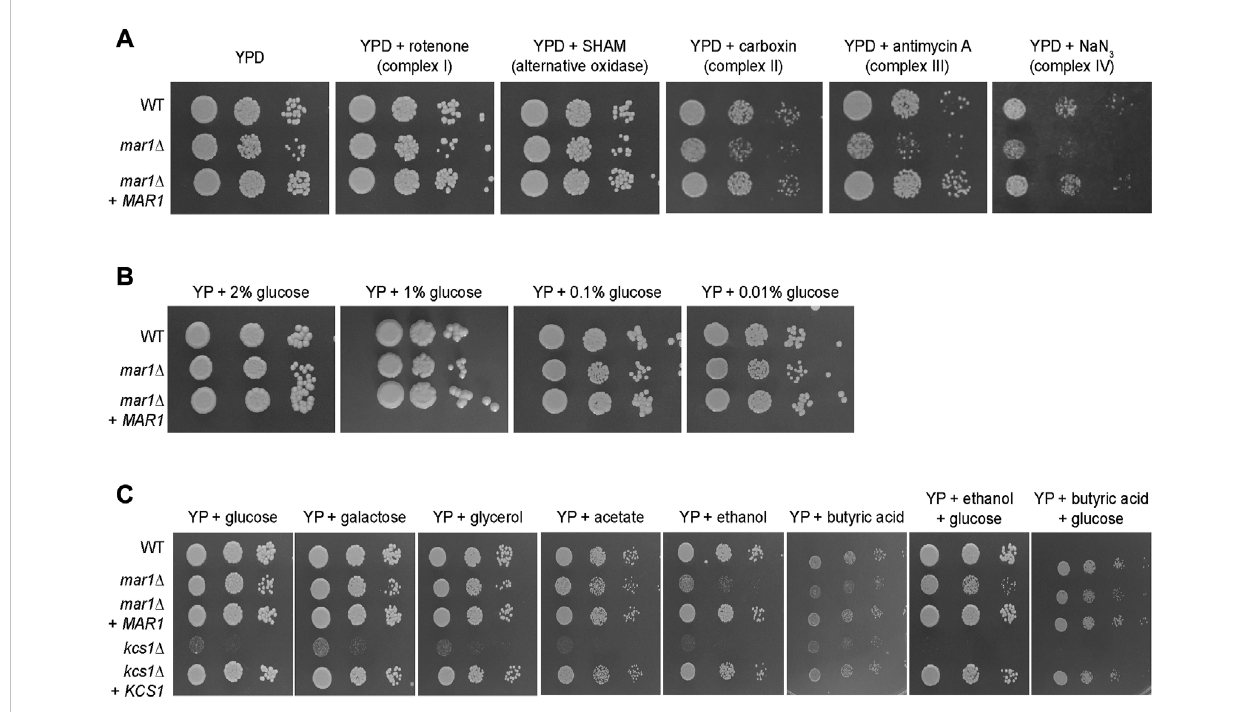
FIGURE 3 Mar1 contributions to electron transport chain function and carbon source utilization. (A) Growth phenotypes of the WT strain, the mar1 Δ mutant strain, and the mar1 Δ + MAR1 complemented strain were assessed in the presence of electron transport chain inhibitors. Strains were normalized by OD 600 and were subsequently grown on YPD medium agar plates supplemented with rotenone (0.5 mg/mL), salicylhydroxamic acid (SHAM) (2.5 mM), carboxin (0.1 mg/mL), antimycin A (3 μ g/mL), and sodium azide (NaN 3 ) (0.5 mM) at 30 ° C. Plates were imaged daily. Experiment was repeated two times to ensure reproducibility and representative images are shown. (B) Growth phenotypes of the WT strain, the mar1 Δ mutant strain, and the mar1 Δ + MAR1 complementedstrainwereassessedinthepresenceofcarbondeprivation.StrainswerenormalizedbyOD 600 andweresubsequentlygrownonYP medium agar plates supplemented with 2% glucose, 1% glucose, 0.1% glucose, and 0.01% glucose at 30 ° C. Plates were imaged daily. Experiment was repeated twotimesto ensurereproducibilityandrepresentativeimages areshown. (C) Growthphenotypes oftheWTstrain,the mar1 Δ mutantstrain,the mar1 Δ + MAR1 complemented strain, the kcs1 Δ mutant strain, and the ksc1 Δ + KCS1 complemented strain were assessed in the presence of alternative carbon sources. Strains were normalized by OD 600 and were subsequently grown on YP medium agar plates supplemented with glucose (2%),